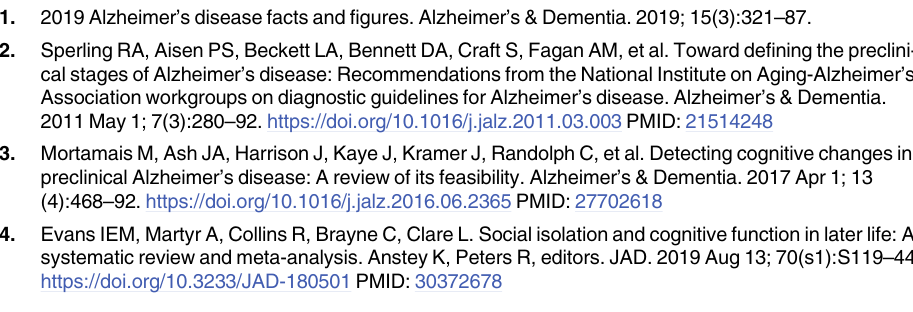
S1 Table. Summary of the one-day lagged effects of daily cognitive performance on daily social interactions. S2 Table. Summary of the two-day lagged effects of daily cognitive performance on daily social